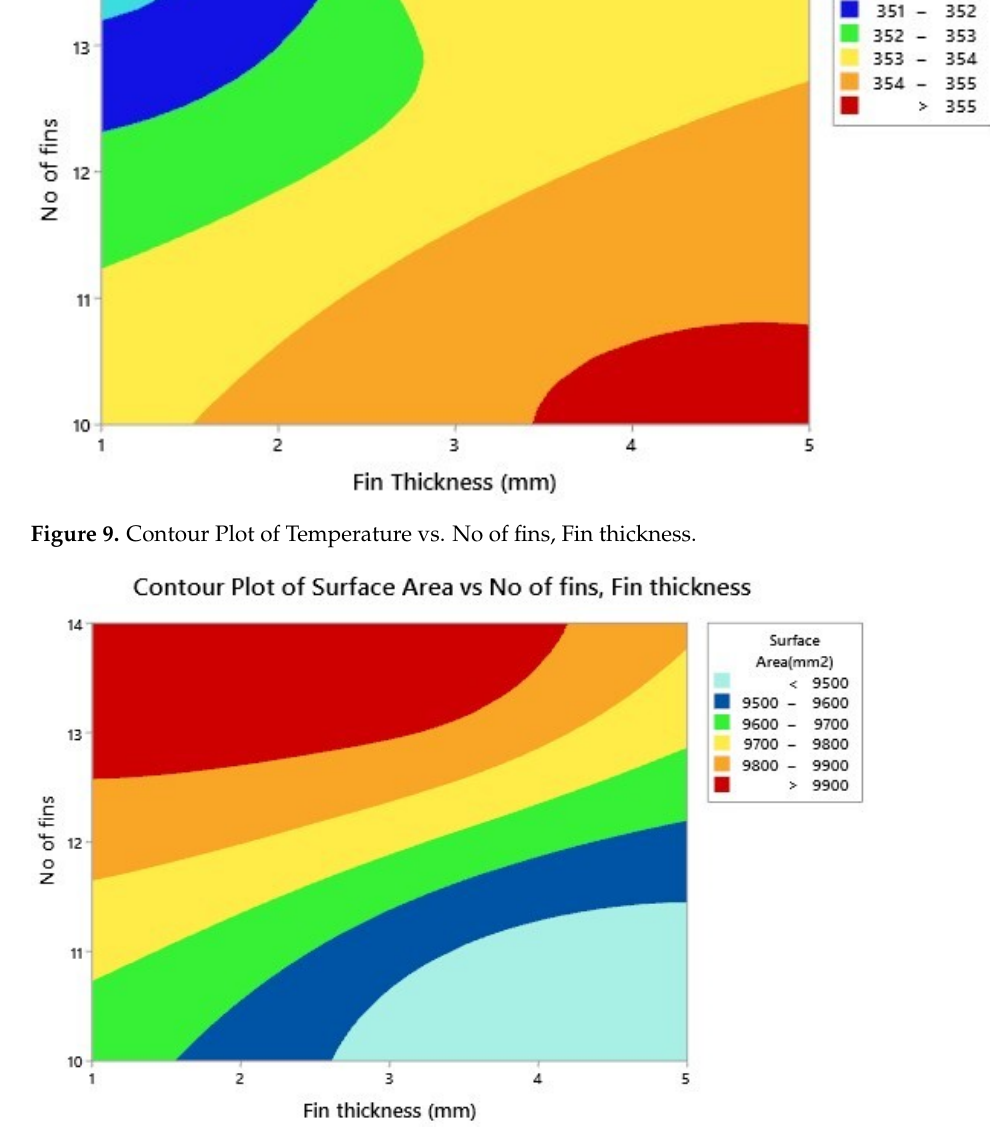
Figure 10. Contour Plot of Surface Area vs No of fins, Fin thickness.